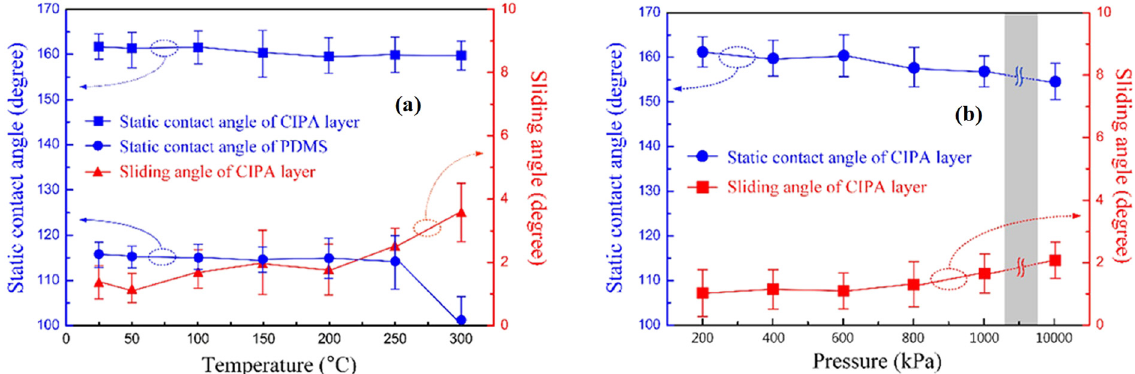
Figure 6: Stability test results of CNT - incorporated PDMS/adhesive ( CIPA ) layer with ( a ) heat and ( b ) pressure [ 139 ] . Reproduced with permission from ref. [ 139 ] ( https://pubs.acs.org/doi/10.1021/acsomega.7b01872 ) ; © 2018 American Chemical Society. For further per - missions related to the material excerpted should be directed to the